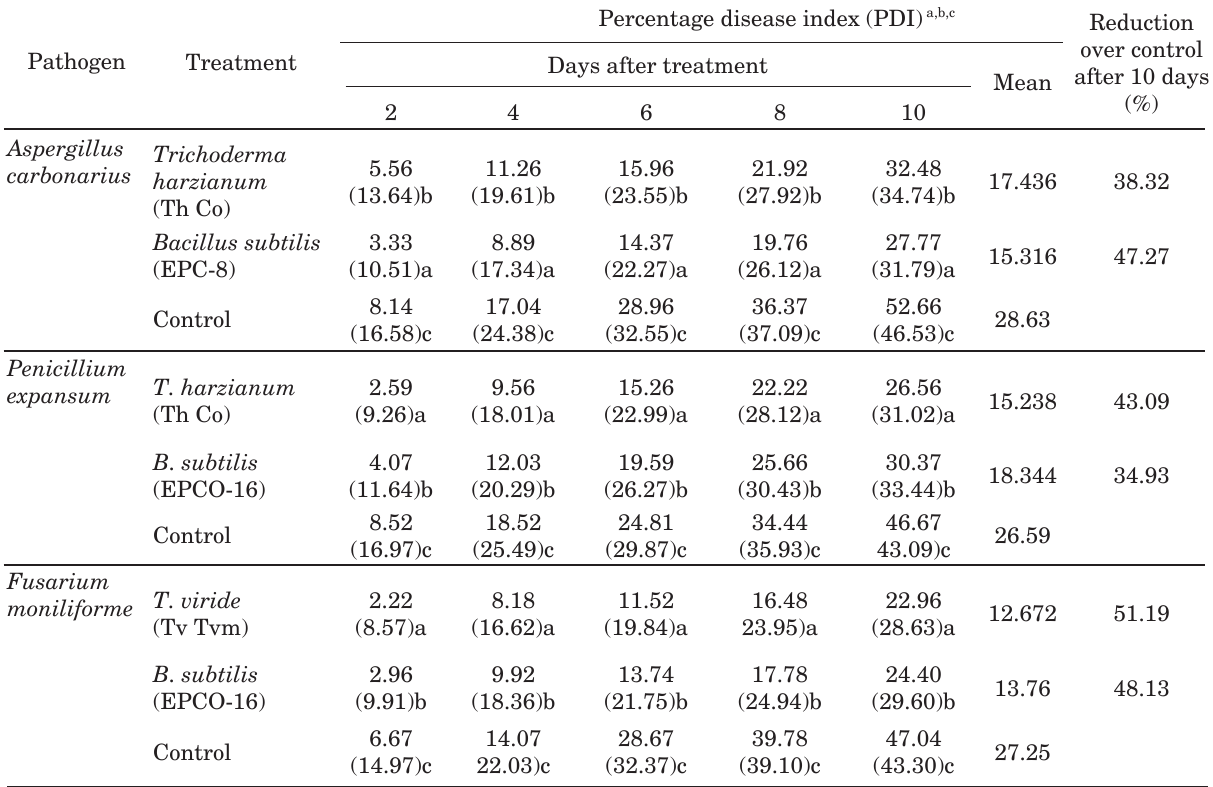
Table 4. Effect of post inoculation of antagonists on the incidence of postharvest rot disease in grapes.